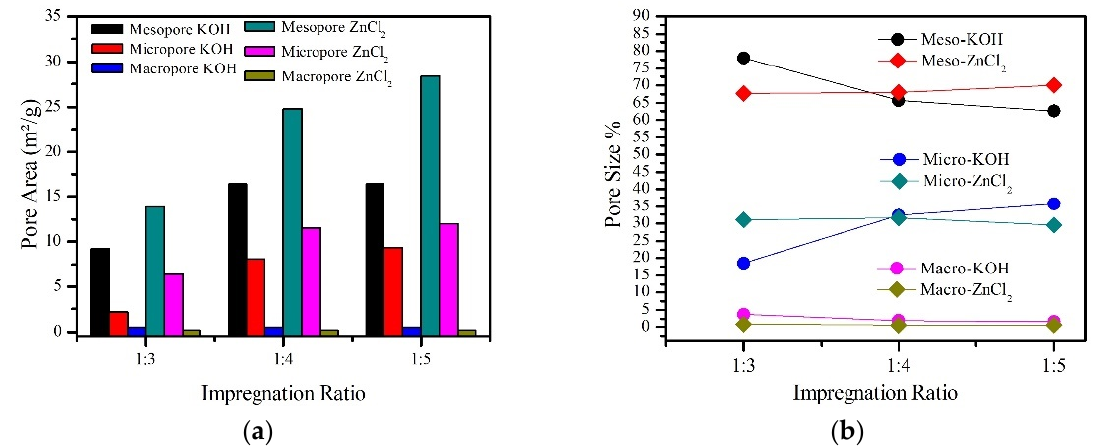
Figure 4. ( a ) Barrett–Joyner–Halenda (BJH) adsorption pore area distribution; ( b ) pore size distribution for RFSFACs, prepared with different activating agents and impregnation ratios.